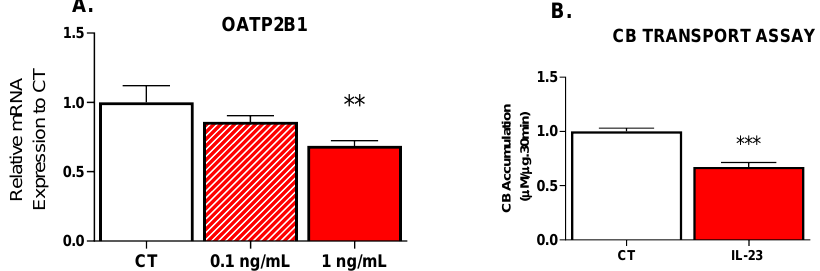
Figure 3. Effect of IL-23 on the ( A ) mRNA expression of OATP2B1 and ( B ) intracellular accumulation of Cascade Blue (CB) in JAr cells. JAr cells were treated with IL-23 or media (CT) for 24 h, and either collected for RNA or used for the CB transport assay, as described in methods. Three or four replicates were run in three separated experiments ( n = 3). Data are presented as mean ± SEM. ** p < 0.01, *** p < 0.001.